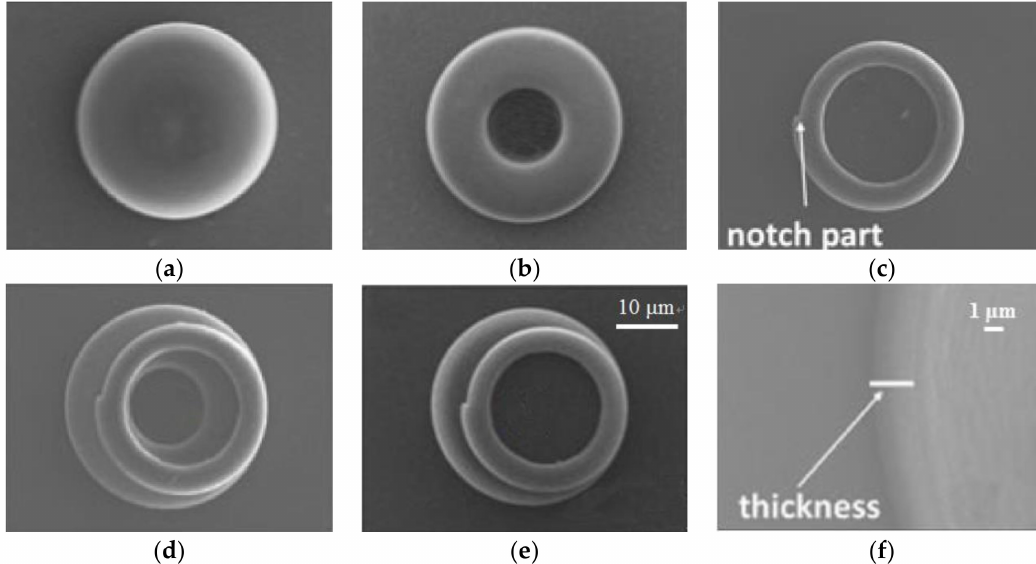
Figure 8. The SEM image of three different construction microlasers with ( a ) circular disk; ( b ) circular ring; ( c ) spiral ring; ( d ) a spiral ring stacked on a circular ring; ( e ) a spiral ring stacked on a circular disk; and ( f ) the tilt-view magnified SEM image of the circular ring in ( d )